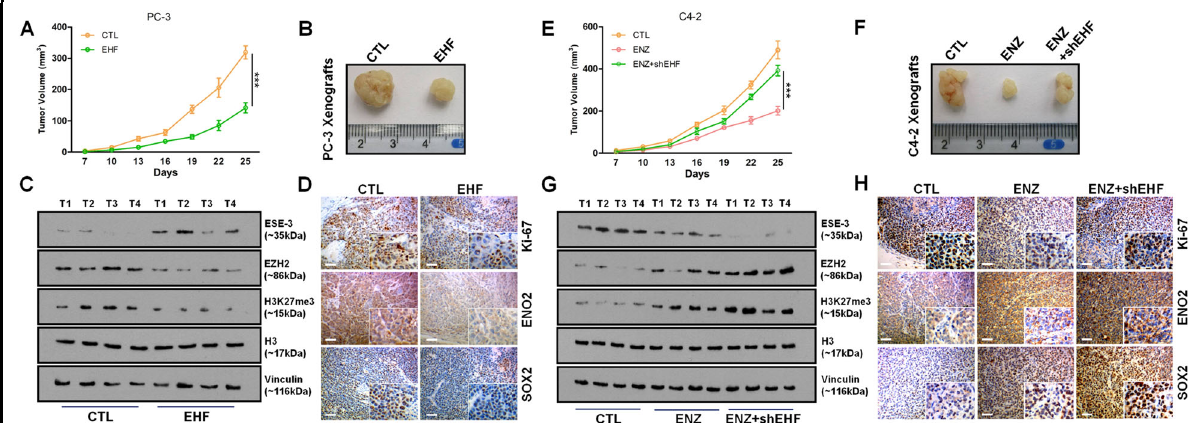
Fig. 6 EHF loss contributes to the progression of CRPC and NE differentiation in mice. A Growth of tumor xenografts in male nude mice 25 days after subcutaneous inoculation with PC-3 cells with/without EHF overexpression. n = 4 mice per group. B Representative tumor images in ( A ). C EHF, EZH2, H3K27me3, and H3 protein expressions from the xenografts in ( A ) were measured by immunoblotting. D Ki-67, ENO2, and SOX2 expressions from the xenografts in ( A ) were measured by immunohistochemistry. Scale bar 100 μ m. E Growth of tumor xenografts in male nude mice treated with/without ENZ (30 mg/kg, intraperitoneal injection, every other day) 25 days after subcutaneous inoculation with C4-2 cells with/ without EHF knockdown. n = 4 mice per group. F Representative tumor images in ( E ). G Same proteins in ( C ) from the xenografts in ( E ) were measured by immunoblotting. ( H ) Same markers in ( D ) from the xenografts in ( E ) were measured by immunohistochemistry. Scale bar 100 μ m. The two-tailed Student ’ s t test or one-way ANOVA, followed by Dunnett ’ s t test was used to compare results between two groups with *** denoting p < 0.001. Immunoblotting assays were repeated in triplicate. Bar graphs show means ± SD.